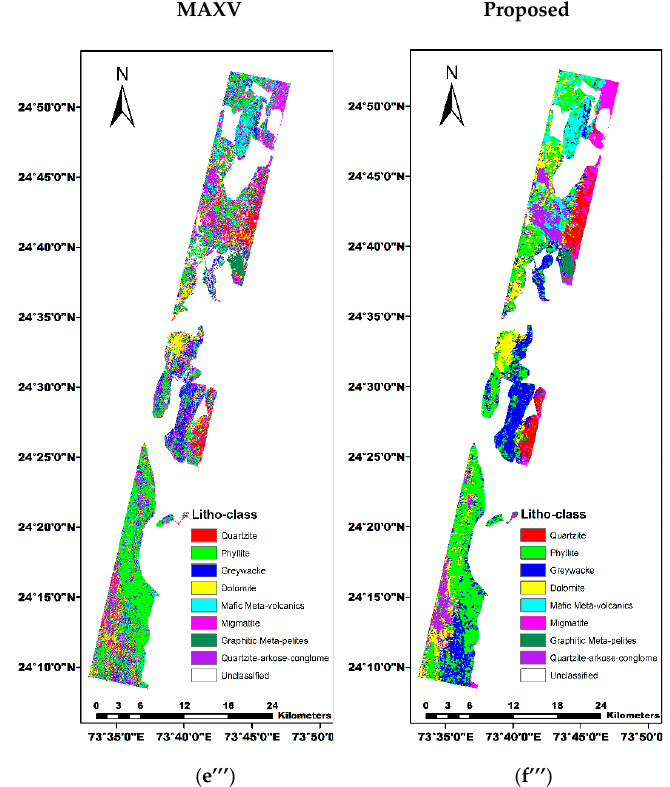
Figure 3. Lithological mapping, using Hyperion image by MD ( a ), SAM ( b ), SID ( c ), SVM ( d ), MAXV ( e ), and proposed method ( f ); using ASTER image by MD ( a’ ), SAM ( b’ ), SID ( c’ ), SVM ( d’ ), MAXV ( e’ ), and proposed method ( f’ ); using Landsat 8 image by MD ( a” ), SAM ( b” ), SID ( c’ ’), SVM ( d” ), MAXV ( e” ), and proposed method ( f” ); and using combined (Hyperion, ASTER, and Landsat 8) images by MAXV ( e”’ ) and proposed method ( f”’ ) of the study area. where d is the spectral distance, r i and y i are average reflectance in band i from all and individual training samples of the lithological units respectively, and n is the number of spectral bands. Table 1. ( a ) Classification accuracy assessment. ( b ) Cross-validation overall accuracy (%) for classification accuracy assessment. ( a ). Hyperion Lithoclass/